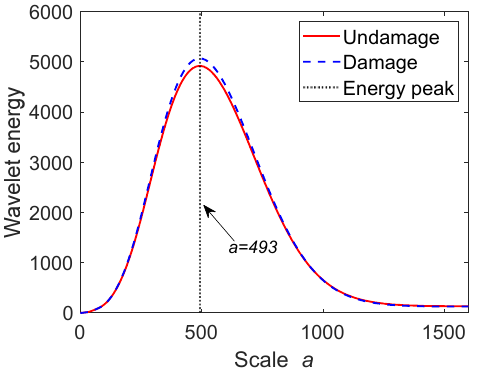
Figure 10. Wavelet energy for different bridge conditions.